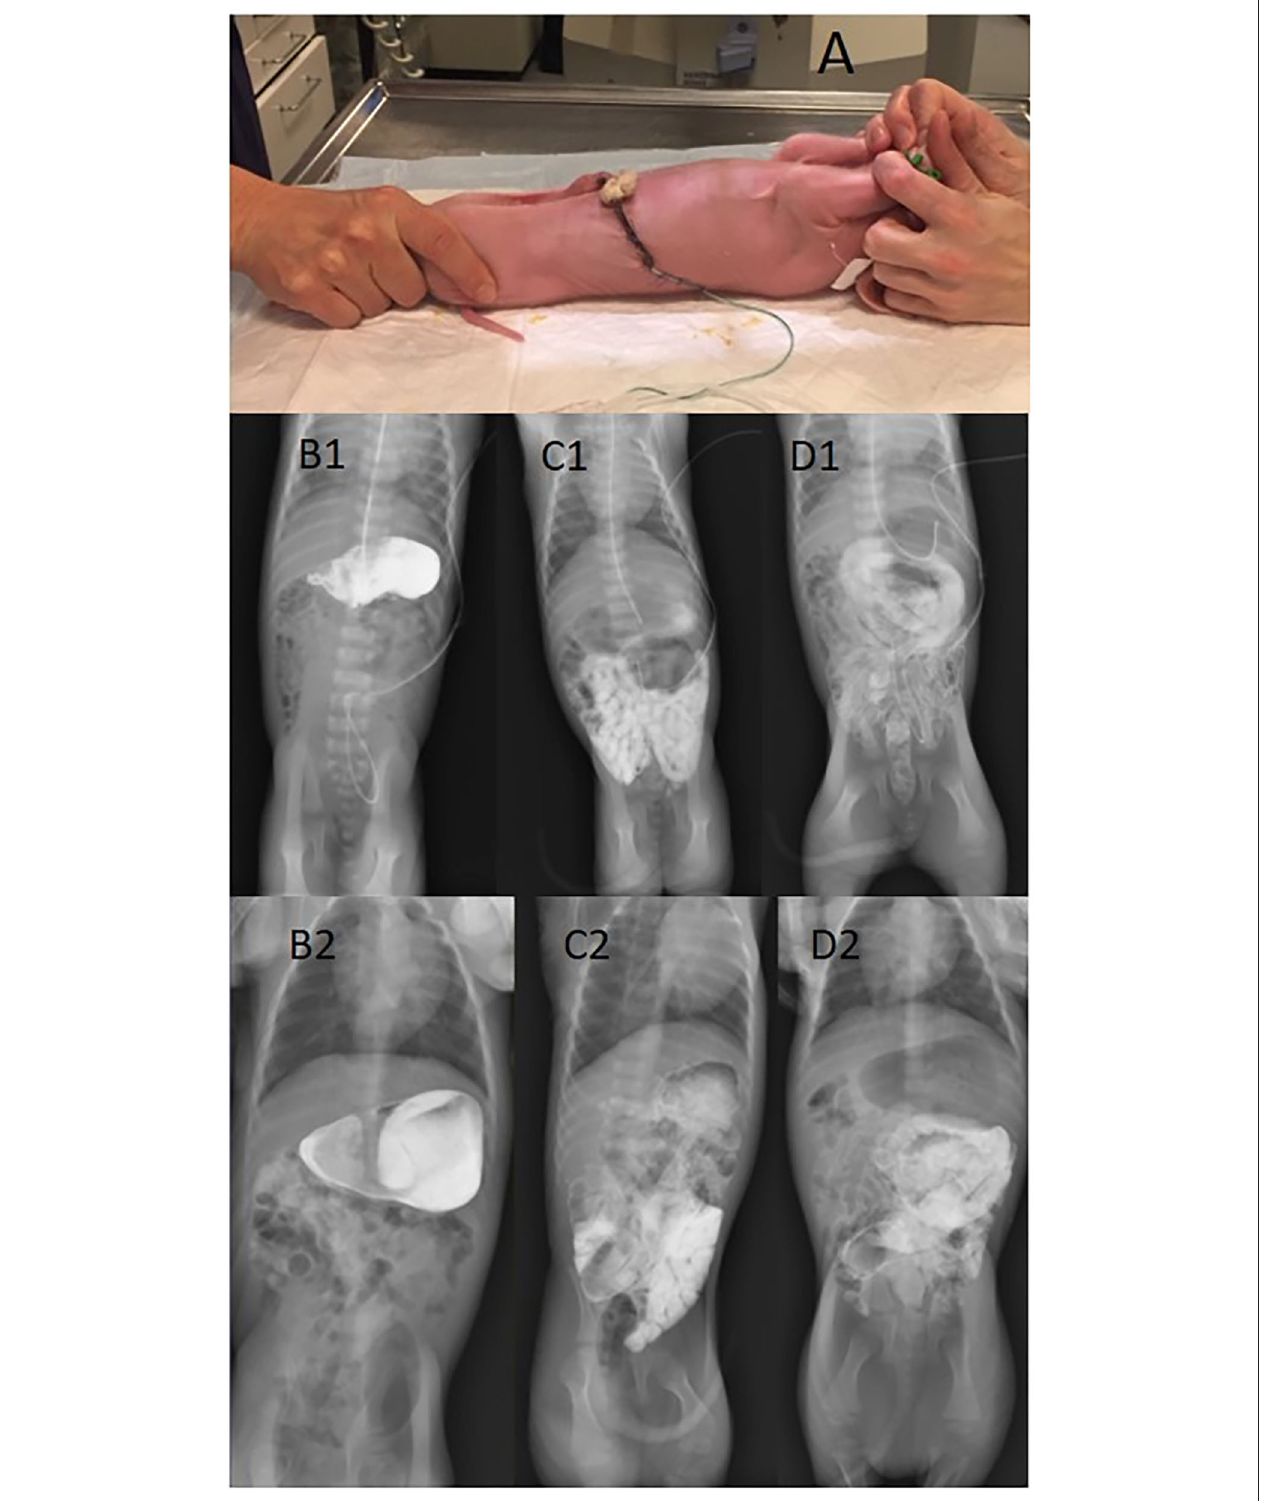
FIGURE 1 | Contrast X-ray imaging of preterm piglets placed in lateral recumbence for taking the X-ray picture (A) . The figure also shows a stomach filled with contrast solution (B1, B2) , contrast reaching the caecum (C1, C2) , and contrast in colon and rectum with a near-empty small intestine (D1, D2) . Upper panel: 4 days of age; lower panel: 18 days of